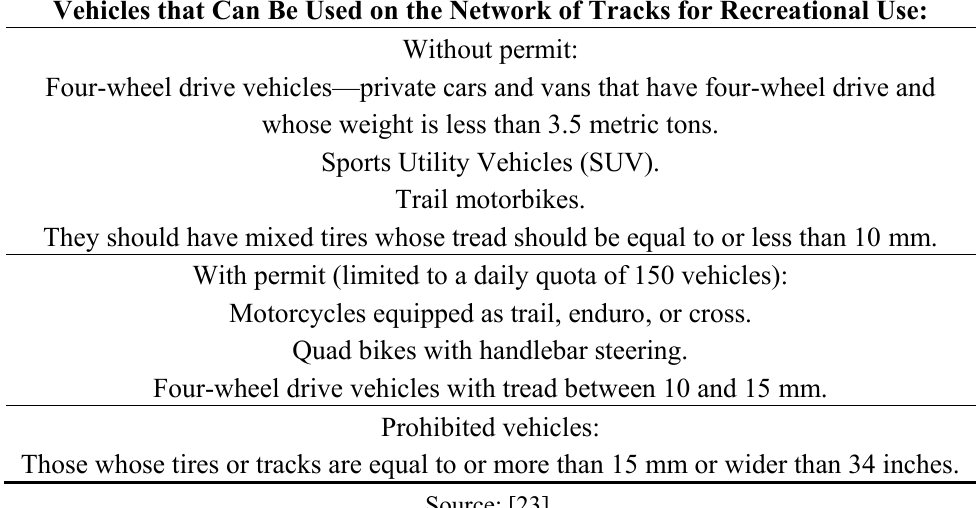
Table 1. Traffic regulations on forest